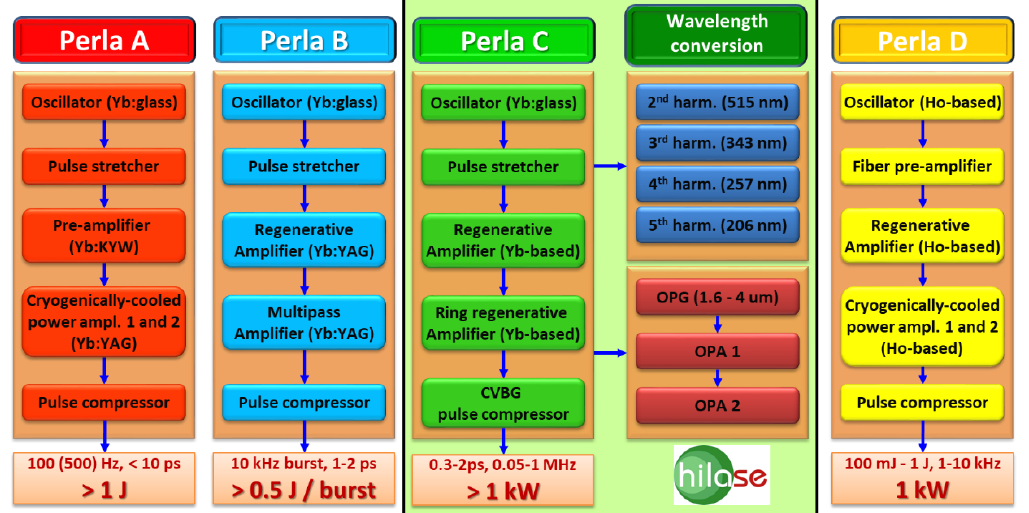
Figure 1. Actual scheme and target parameters of thin-disk based beamlines and frequency conversion stages, which are operated or under construction at the HiLASE Center in 2017. CVBG: chirped volume Bragg grating-based; OPG: optical parametric generation; OPA: optical parametric